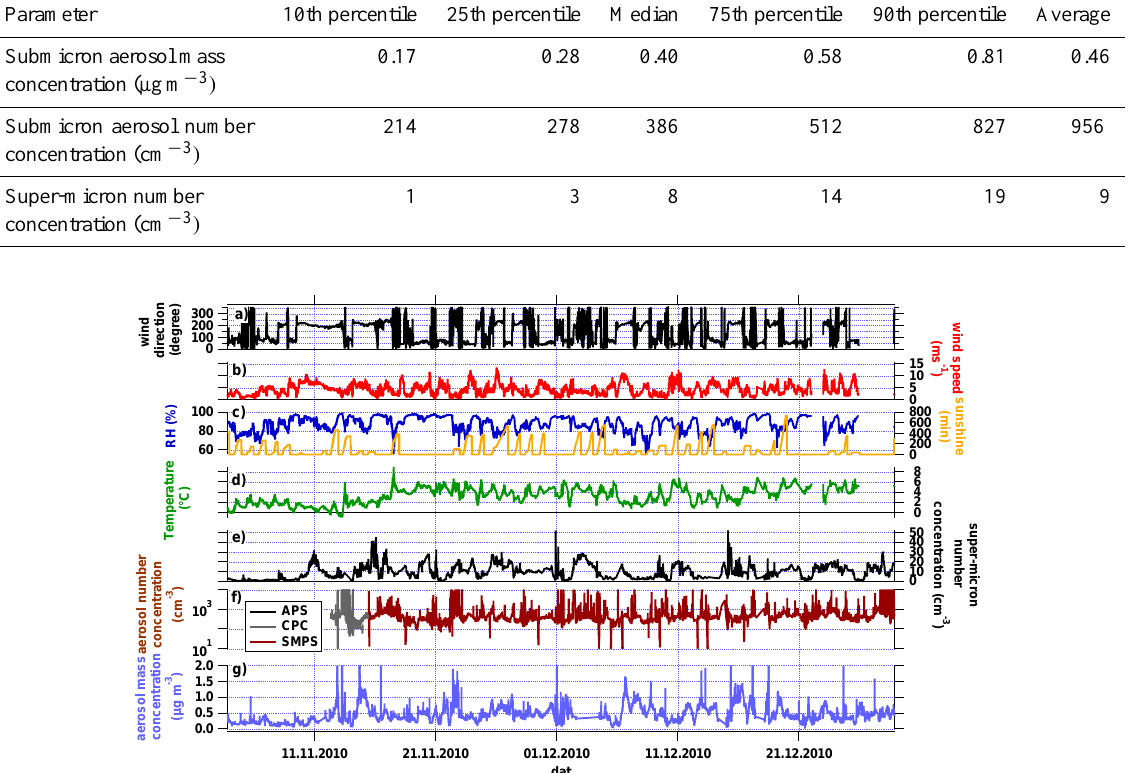
Fig. 2. (a–d) Meteorological data for Bird Island during the campaign from local measurements. The minutes of sunshine are accumulated for each day. (e) Super-micron aerosol number density measured by the APS, (f) submicron aerosol number density measured by a CPC and SMPS and (g) submicron aerosol mass concentration as derived by the